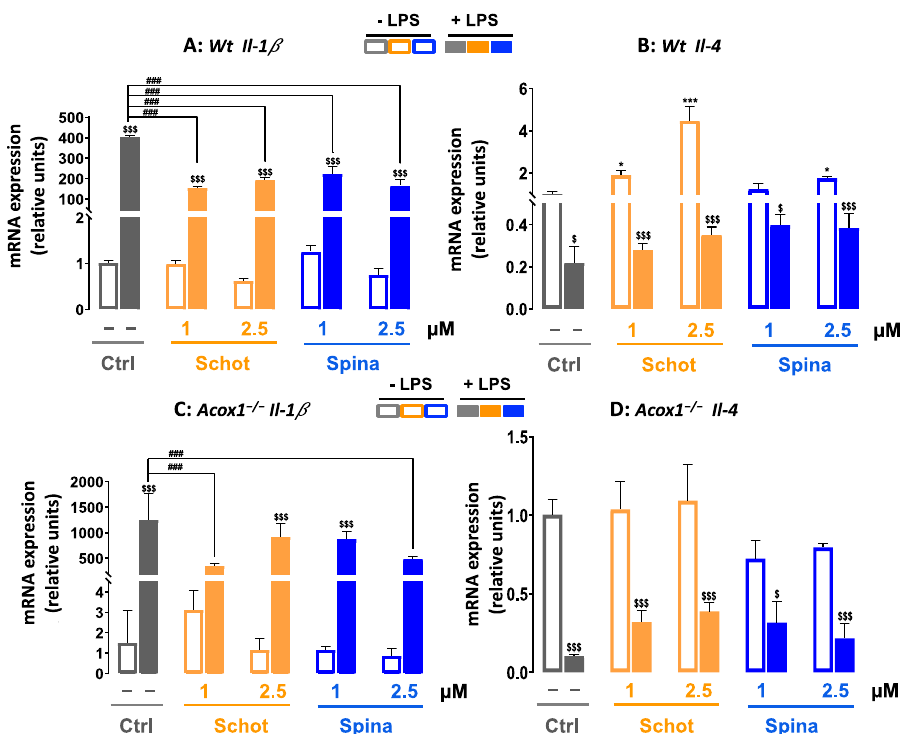
Figure 10. Effect of Schot and Spina treatment on the gene expression of the proinflammatory marker Il-b ( A , B ) and the anti-inflammatory marker Il-4 ( C , D ) in the Wt ( A , C ) and Acox1 − / − ( B , D ) BV-2 microglial cells. Cells were incubated for 24 h with Schot or Spina (1 or 2.5 µM) in the absence or presence of LPS (1 µg/mL). Total RNA was isolated from BV- 2 cells, and then the expression level of genes of interest was quantified by real-time RT-qPCR. All values are presented as means ± SD of two independent experiments performed in triplicate, with the statistical significance of the increased mean signal indicated as *** p ≤ 0.001 and * p ≤ 0.05 compared to control; ### p ≤ 0.01 and compared to LPS; and $$$ p ≤ 0.001 and $ p ≤ 0.05 compared to the different treatments with or without LPS administration. Statistical significance was determined using two-way ANOVA followed by Tukey’s test for multiple comparisons.